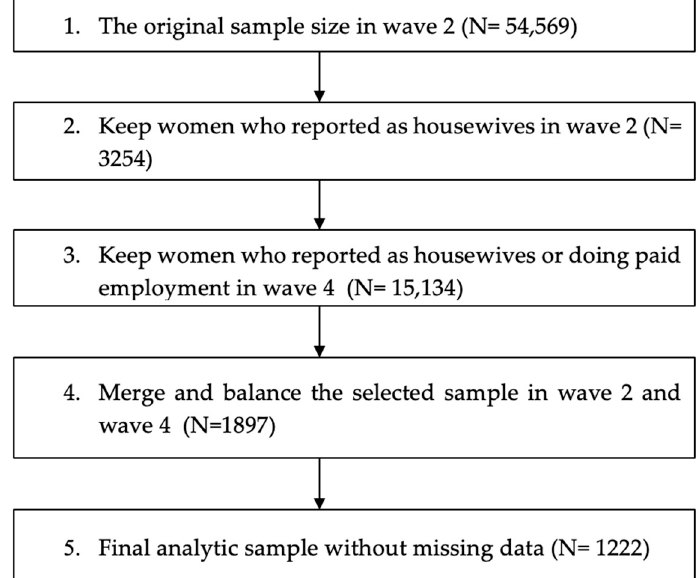
Figure 1. The analytic sample construction process.